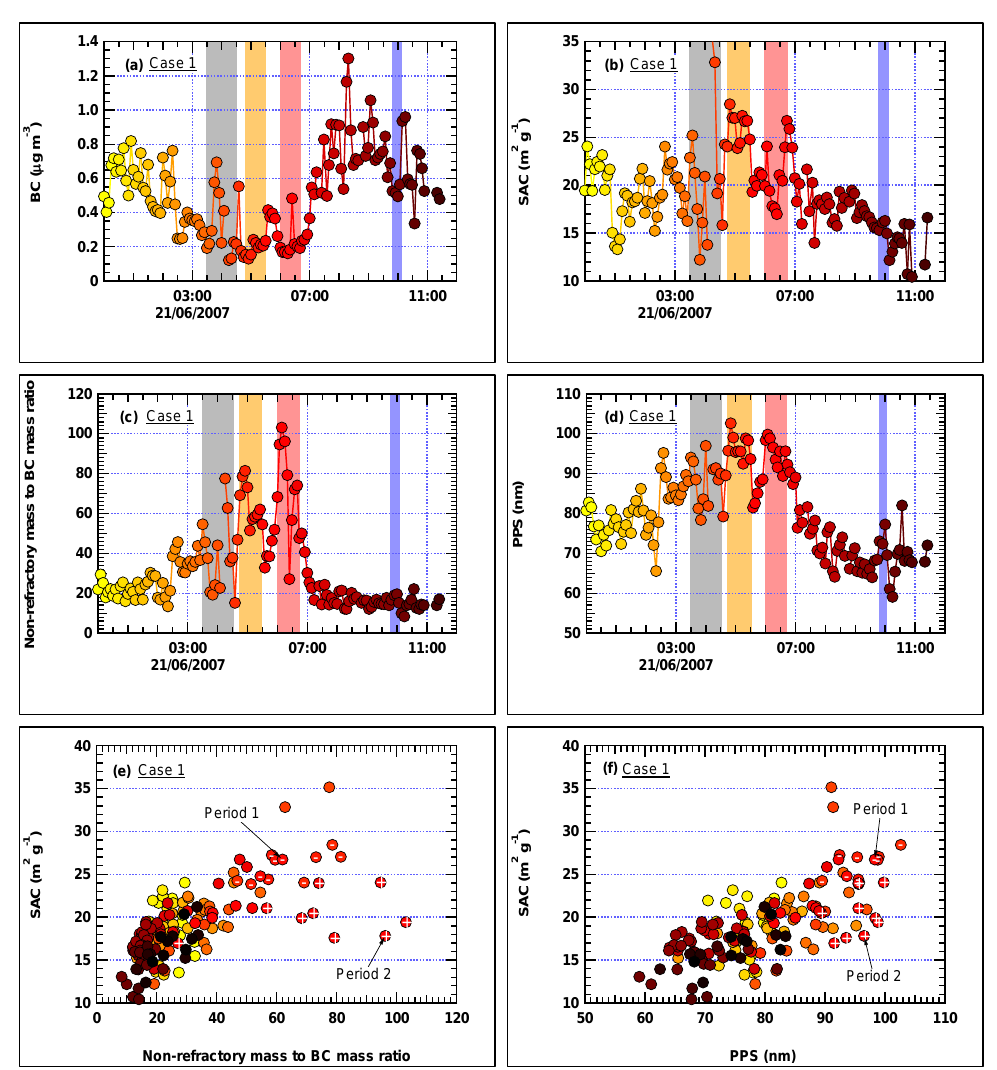
Fig. 4. Time series of five minute average (a) black carbon mass concentration, (b) SAC, (c) non-refractory mass to BC mass ratio, and (d) PPS for 21 June 2007, during the BAQS-Met study. The shaded regions of grey, orange, red, and blue represent the sweep period (03:30–04:30), period 1 (04:40–05:30), period 2 (06:00–06:40), and period 3 (09:50–10:05), respectively. Relationship between the SAC and the non-refractory mass to BC mass ratio is shown in panel (e) while relationship with PPS is shown in panel (f) . Data points in panels (e) and (f) are colored according to the temporal position indicated in panel (a–d) . The data points with the “ − ” and “+” symbols represent the measurements during period 1 and 2, respectively.